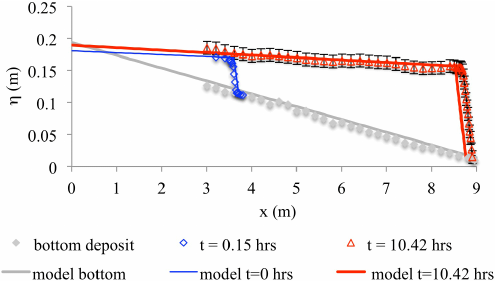
Figure 6. Comparison between measured (diamonds and triangles) and numerical (lines) longitudinal profiles. The profile of the bottom deposit (grey) is a model boundary condition. The delta profile at t =0.15h (blue) is the model initial condition. The delta profile at t =10.42h (red) is a model result. Error bars of the measured profile at t =10.42h denote ±